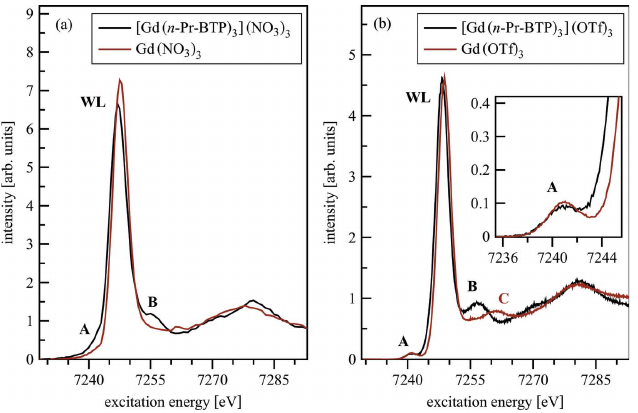
Figure 10 Gd L 3 -edge HR-XANES of [Gd( n -Pr-BTP) 3 ](NO 3 ) 3 and Gd(NO 3 ) 3 ( a ) and [Gd( n -Pr-BTP) 3 ](OTf) 3 and Gd(OTf) 3 ( b